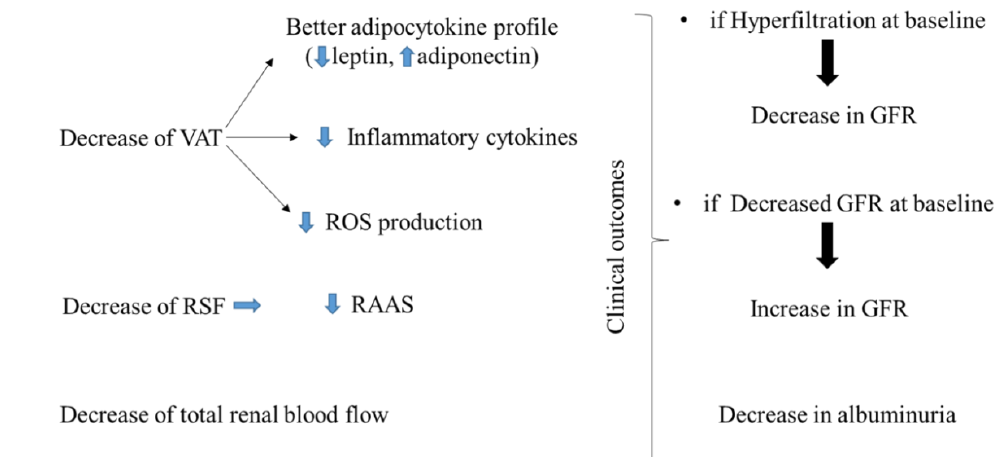
Figure 1. Following bariatric-surgery-induced weight loss, visceral adipose tissue deposits are decreased, as well as renal sinus fat deposits. The decrease in the former contributes to a favorable adipocytokine profile, reduction in inflammatory cytokines, and reduction in ROS production, while the latter might lead to a less-activated RAAS. Decreased total renal blood flow has also been described following bariatric-surgery-induced weight loss. Clinically, following bariatric surgery, the glomerular filtration rate is decreased in patients with glomerular hyperfiltration and increased in patients who already have a more advanced stage of chronic kidney disease. In both stages, albuminuria is decreased. These favorable outcomes ultimately decrease the rate of progression towards a more advanced stage of chronic kidney disease.